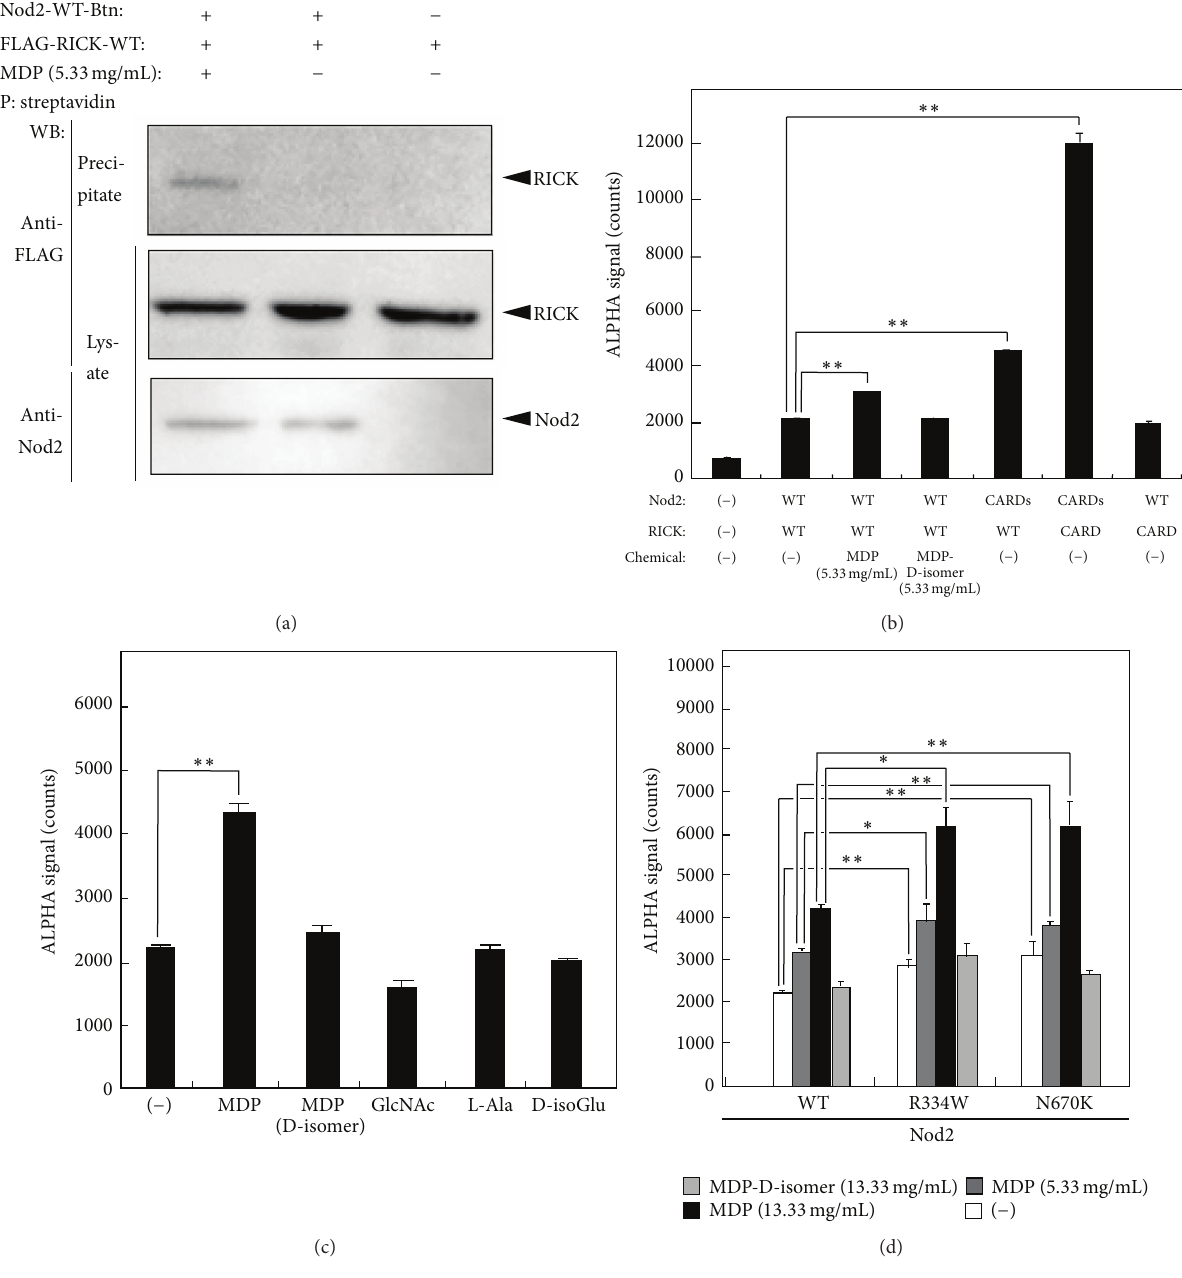
Figure 2: Construction of Nod2-nodosome containing the BS/EOS-associated mutation in a cell-free system. Synthetic protein-protein interactions were detected by pull-down assay and amplified luminescent proximity homogeneous assay (ALPHA). (a) Biotinylated-Nod2- WT (Nod2-WT-Btn) and 1 𝜇 g FLAG-tagged RICK-WT (FLAG-RICK-WT) lysed in 300 𝜇 L NP-40 buffer were precipitated with 20 𝜇 L streptavidin-conjugated agarose beads with or without MDP. The precipitations were subjected to SDS-PAGE and immunoblotting. Detection on the blotting membranes was performed using anti-FLAG mAb M2 or anti-Nod2 mAb. (b) A total of 100ng of each protein indicated was incubated with 5 𝜇 g/mL anti-FLAG mAb M2, 16.67 𝜇 g/mL protein-A-conjugated ALPHA acceptor beads, and 16.67 𝜇 g/mL streptavidin- conjugated ALPHA donor beads for 24 hours, with or without 5.33 mg/mL MDP or 5 mg/mL N-Acetylmuramyl-D-Alanyl-D-Isoglutamine (MDP-D-isomer). Responses (counts) were measured using the EnSpire (cid:3) Multimode Plate Reader. (c) Activation of Nod2-nodosome in a cell-free system by MDP degradation components. Interactions between Nod2-WT-Btn and FLAG-RICK-WT were detected by ALPHA. A total of 100 ng of Nod2-WT-Btn and FLAG-RICK-WT were incubated with 5 𝜇 g/mL anti-FLAG mAb M2, 16.67 𝜇 g/mL protein-A-conjugated ALPHA acceptor beads and 16.67 𝜇 g/mL streptavidin-conjugated ALPHA donor beads for 24 hours, without or with 5.33 mg/mL MDP, 5.33 mg/mL MDP (D-isomer), 5.33 mg/mL N-acetylglucosamine (GlcNAc), 5.33 mg/mL L-alanine (L-Ala), or 5.33 mg/mL